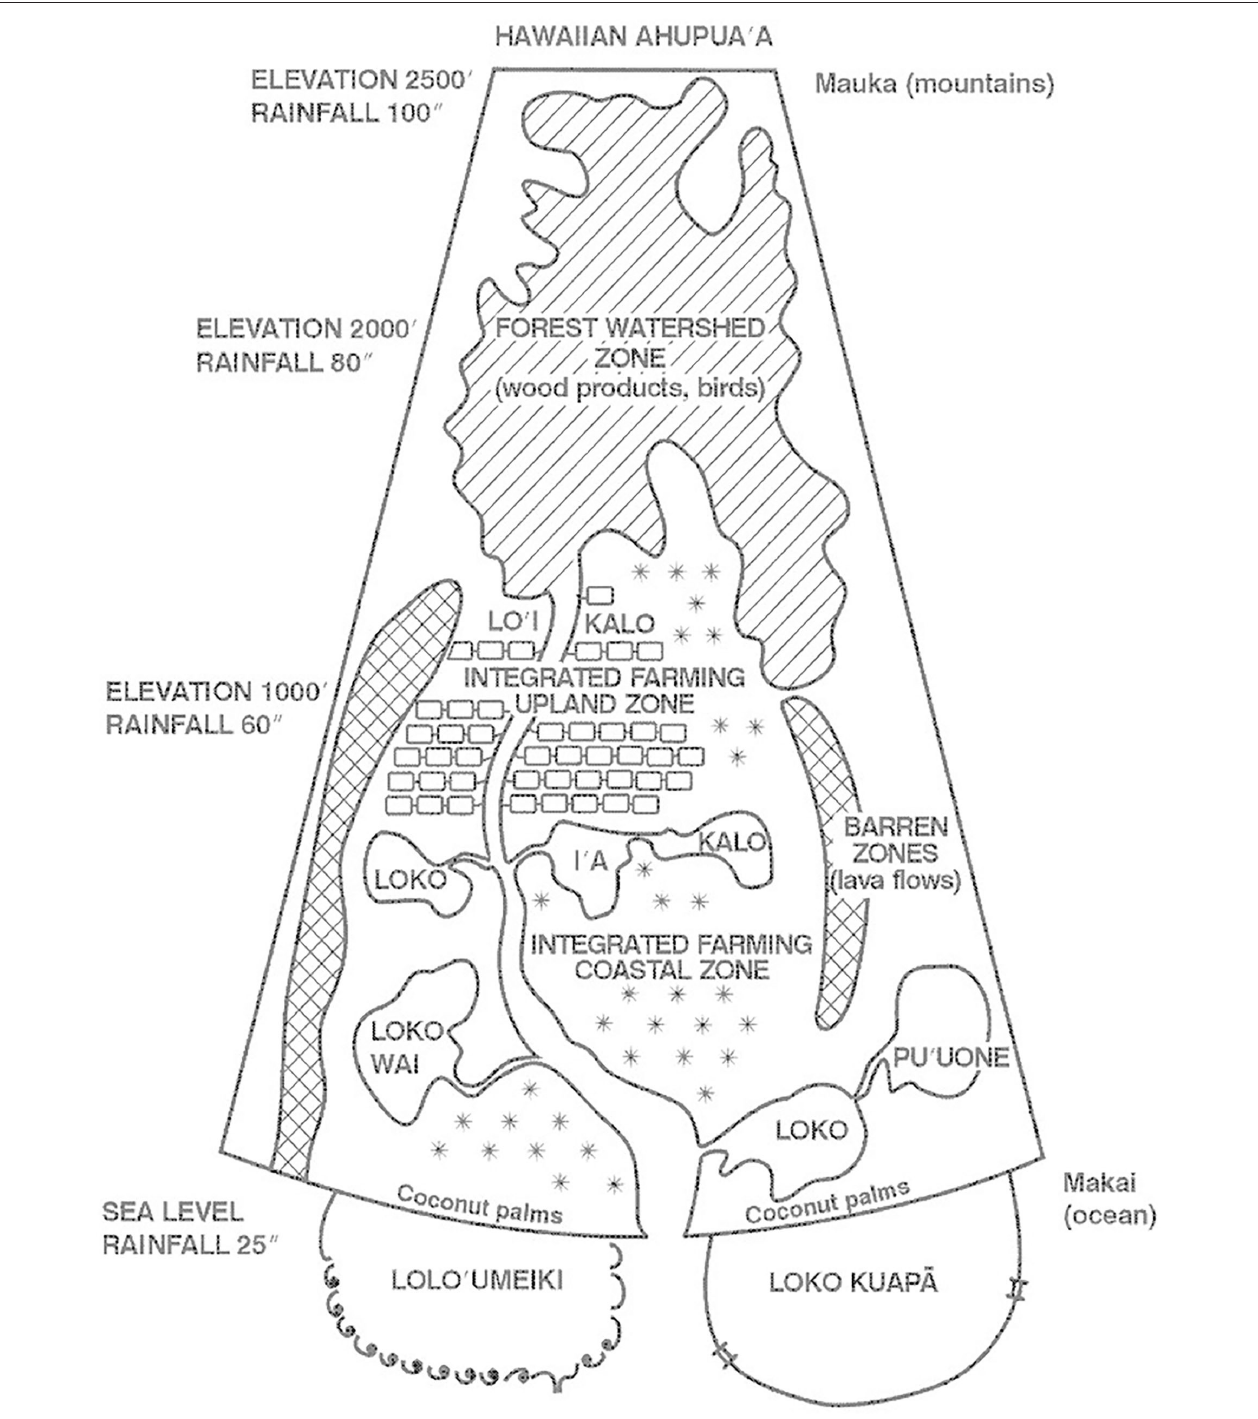
FIGURE 7 | The ahupua’a aquaculture ecosystems stretched from inland highland integrated taro-fishponds, to lakes, reservoirs and ponds in the wetland lowlands to sophisticated marine aquaculture systems built out into nearshore oceans. They sustained a high population density of Hawaiians until European contact (Kikuchi, 1973, 1976; Costa-Pierce, 1987; Gon and Winter, 2019; Winter et al., 2020). Reproduced with permission from the author (B.A. Costa-Pierce).